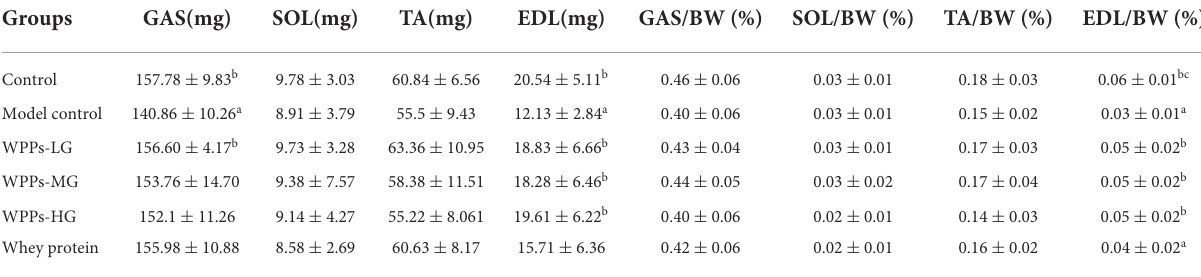
Musclemassandmuscleweight/bodyweight(BW)forgastrocnemius(GAS),soleus(SOL),tibialisanterior(TA),andextensordigitorumlongus(EDL)wasareexpressedasmeans ± SD ( n = 12). a p < 0.05 indicates significant difference versus the control group; b p < 0.05 indicates significant difference versus the model group; c p < 0.05 indicates significant